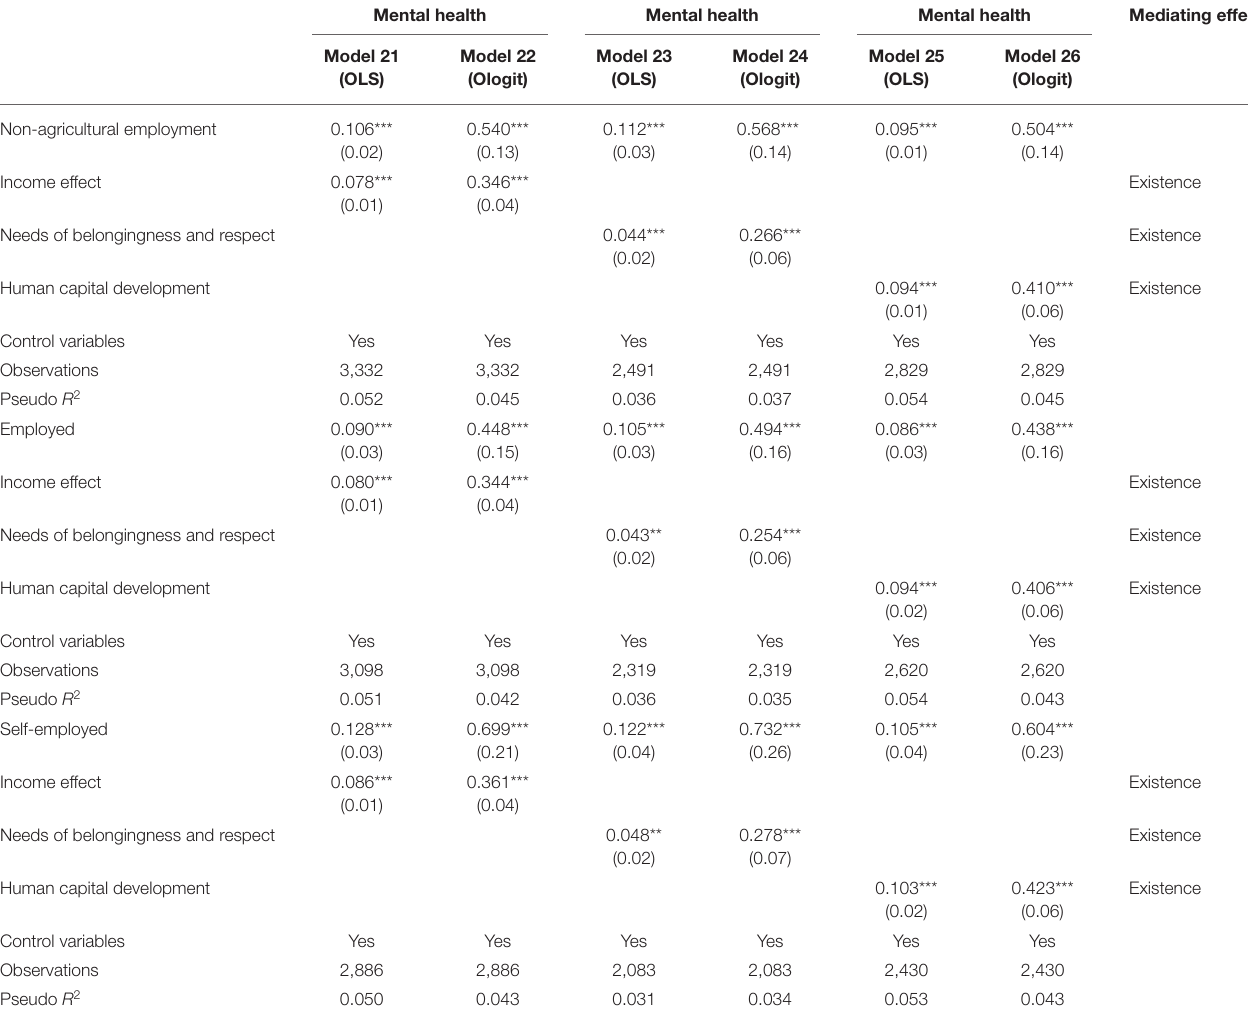
TABLE 8 | Estimation results after adding independent variables and intermediary